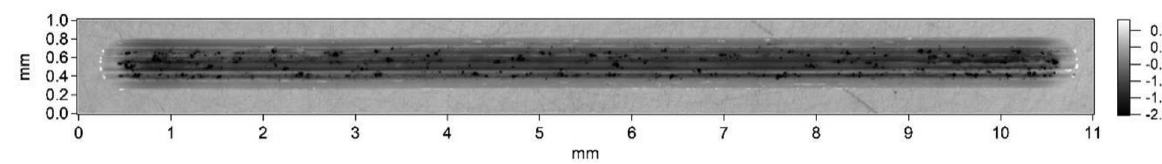
FIGURE 5 | WLI image of a wear track on the plane.